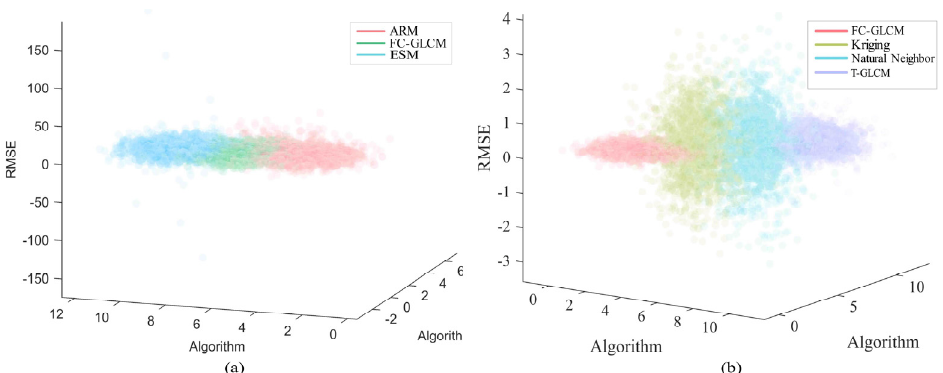
Figure 14. Comparison of RMSE index between the proposed FC-GLCM and classic algorithm. ( a ) Comparison of the proposed FC-GLCM method with the ARM and ESM; ( b ) comparison of the proposed FC-GLCM method with the Kriging, natural neighbor, and T-GLCM approaches.